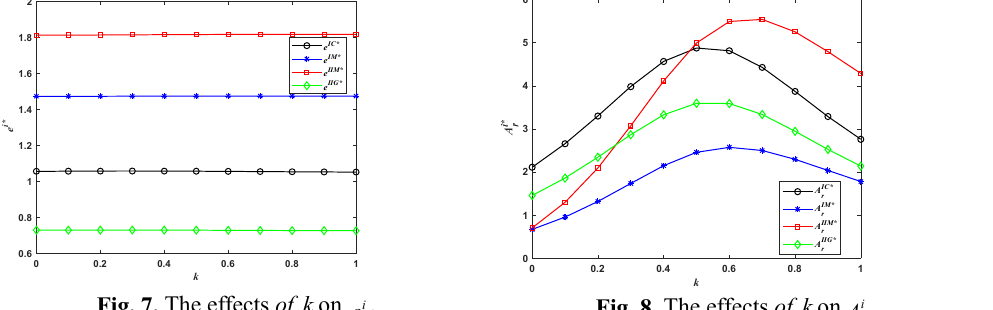
f , i f , i f and i m r